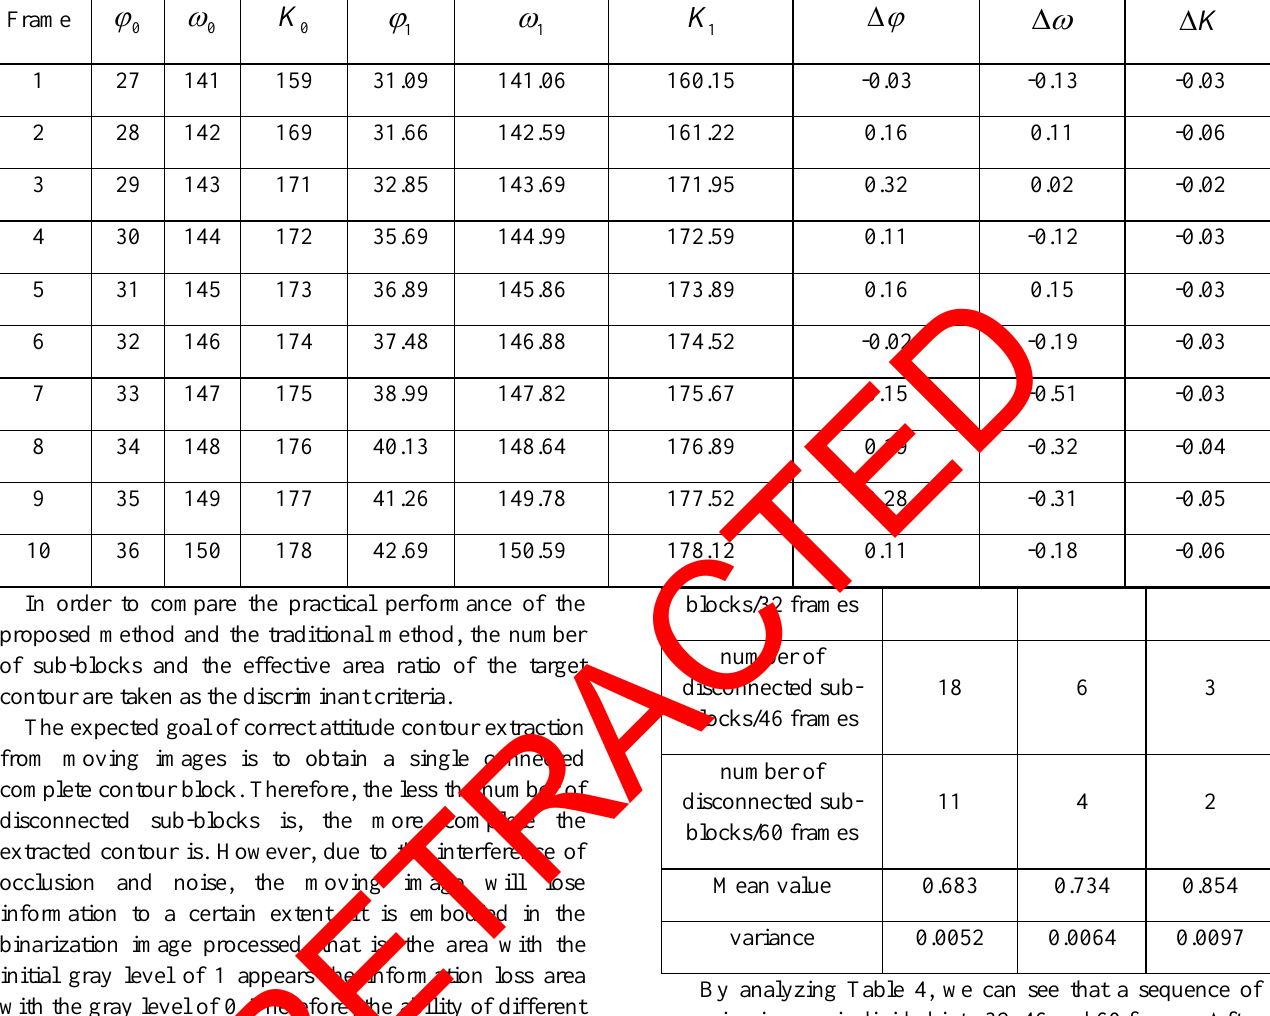
Table 3. Solution results of human body posture